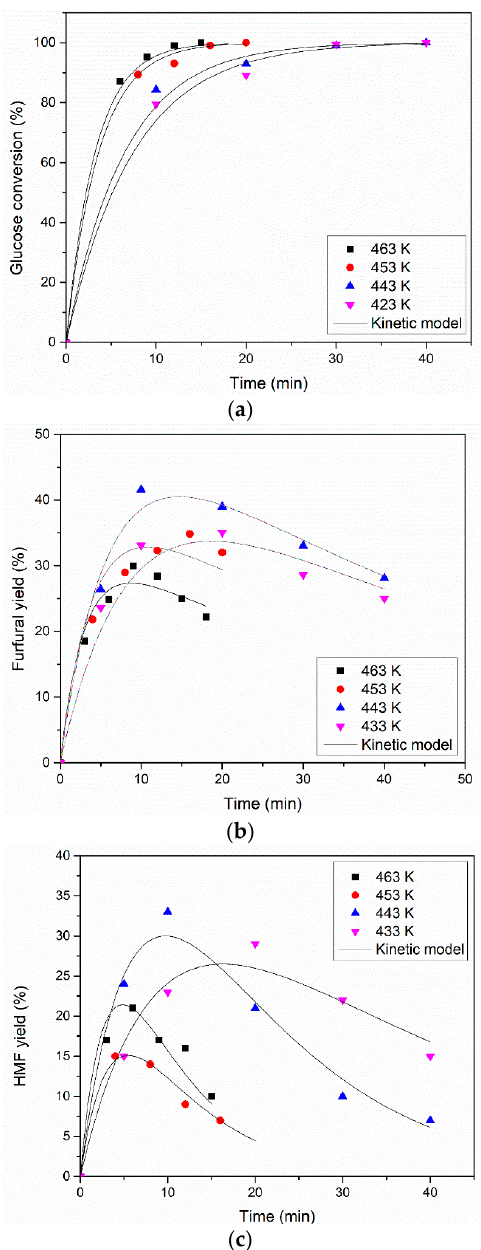
Figure 1. Comparison of experimental data and kinetic models for ( a ) glucose conversion and the production yields of ( b ) furfural production and ( c ) HMF production as a function of temperature. Reaction conditions: 0.0555 mol L − 1 glucose; 1.6 mL GVL; 0.4 mL water; 0.1 wt% H 2 SO 4 ; and 0.014 mol L − 1 SnSO 4 .